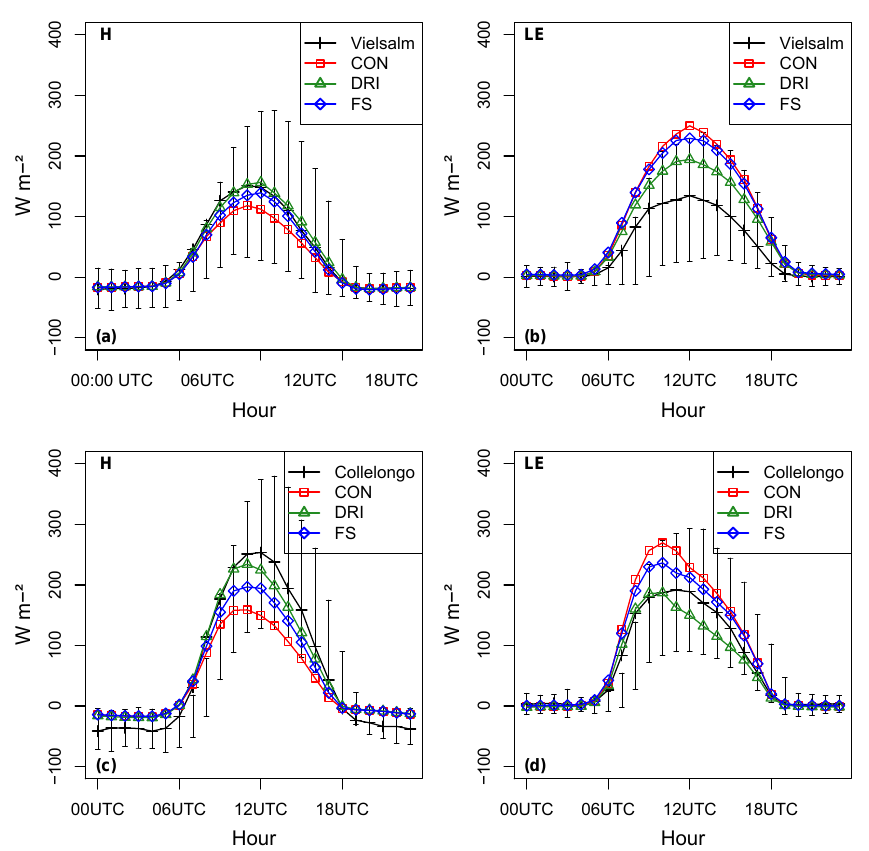
Figure 7. Daily cycle of the energy fluxes (Wm − 2 ) in JJA 1996–2000 for Vielsalm in the top row and Collelongo in bottom row for (a, c) H, and (b, d) LE, for the FLUXNET observations and their corresponding model grid points by CON, DRI and FS. The error bars represent the estimated uncertainties of the observed turbulent